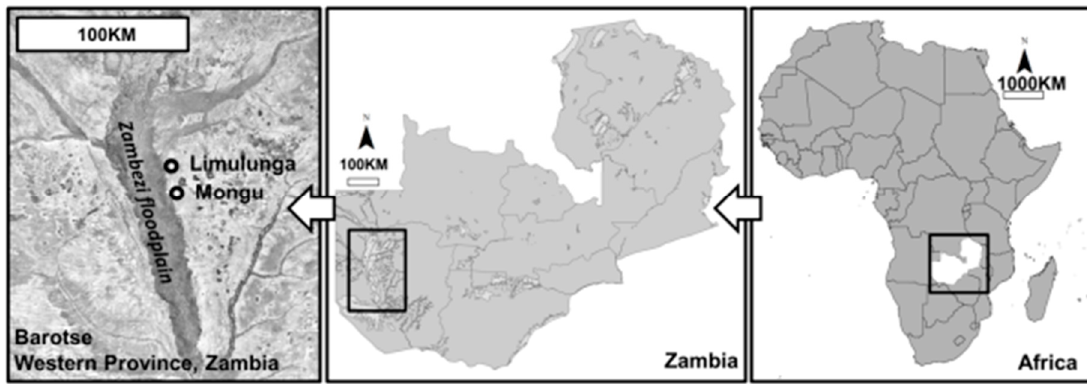
Figure 1. The Barotse floodplain in Western Province, Zambia. Smallholder cattle farmers were sampled that provided milk to the Limulunga (Tukongoti) and Mongu dairy cooperatives and kept their cattle in the floodplain immediately to the west of these towns.